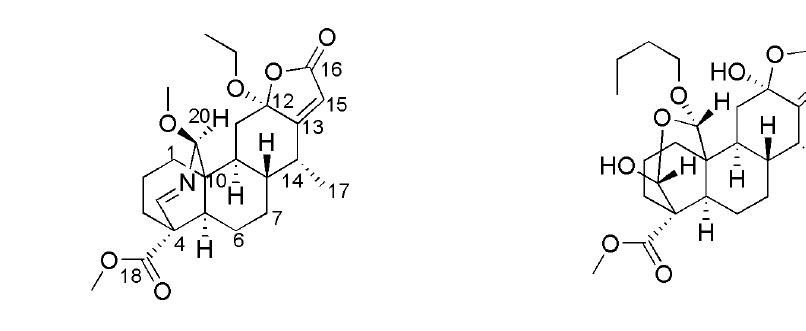
Figure 1. The structures of compounds 1 – 2 .